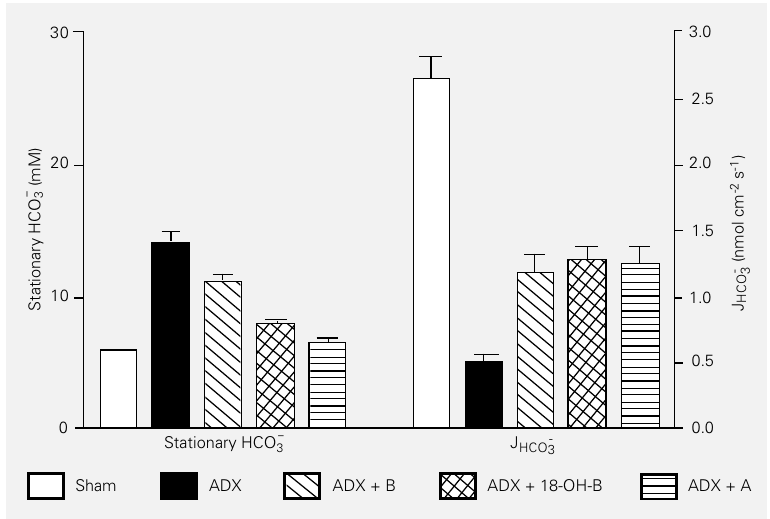
Figure 2 - Stationary bicarbonate concentrations (HCO 3- s) and net bicarbonate reabsorption (J HCO3- ) in proximal tubules from sham-operated and ADX rats. Experimental groups as in Figure 1. Data from Ref. 21, with